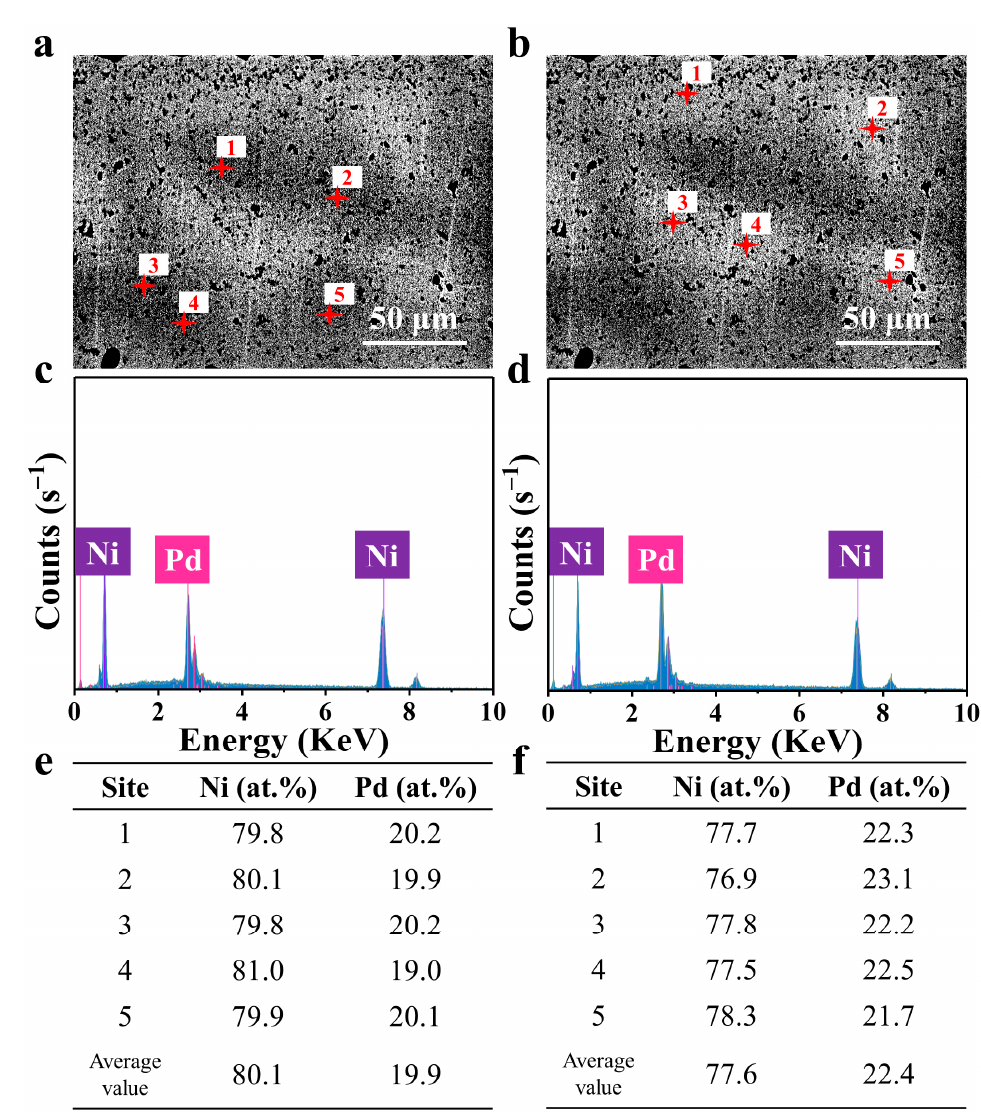
Figure 3. Spot-analysis results of the as-annealed Ni 80 Pd 20 alloy for ( a , c , e ) the dark and ( b , d , f ) the grey regions, which correspond to two o solid–solution phases with extremely close chemical compositions, respectively.